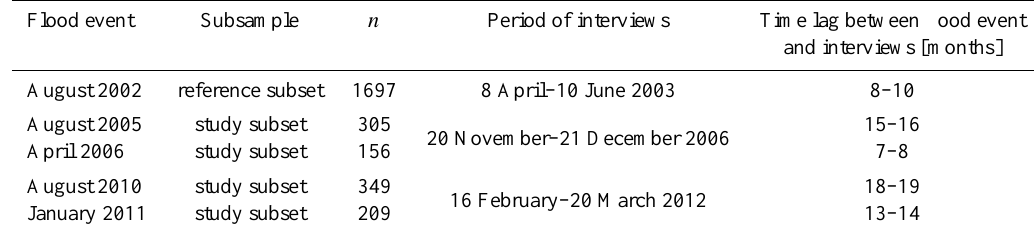
Table 2. Chronological overview of flood events and